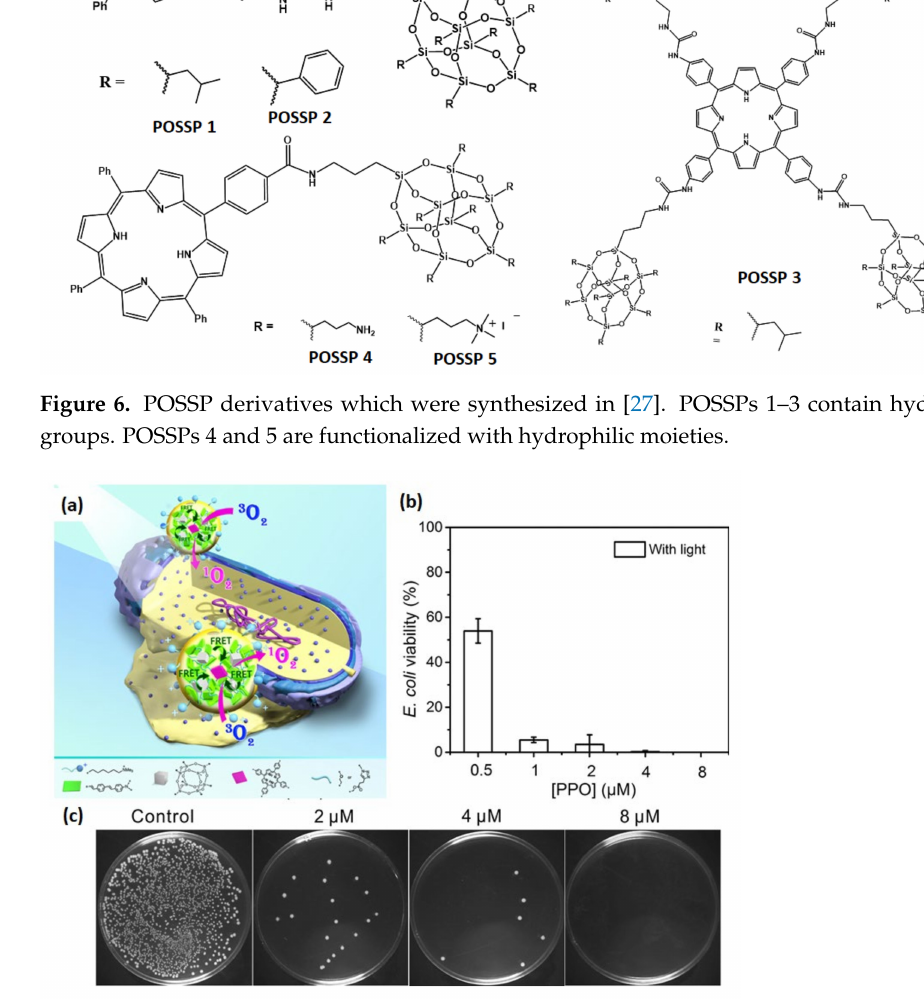
Figure 7. ( a ) Schematic representation of the design and work principle of POSS-porphyrin system. ( b ) Percentage of E. coli viability after treatment with a series of concentrations of PPO under irradiation (12 mW · cm –2 , 10 min). ( c ) Representative photographs of lysogeny broth (LB) agar plates for E. coli treated with a series of concentrations of PPO under white light irradiation. Reprinted with permission from ref. [96]. Copyright 2018 American Chemical